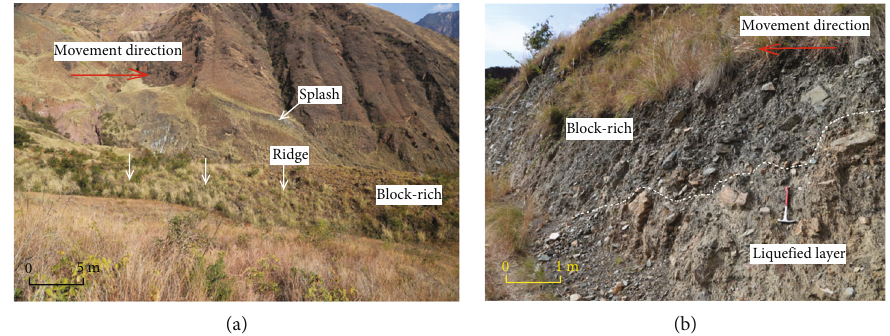
Figure 5: The sedimentary structure in the edge direction of the proximal area of the Luchedu rock avalanche (see Figure 2 for the corresponding position). (a) A raised longitudinal ridge at the edge of the right bank, debris accumulation at the bottom of the ditch on the left bank, and splash area on the slope. (b) The internal sedimentary structure on the inner side of the road (a lique fi ed loess layer with metamorphic rock breccia lies at the bottom).